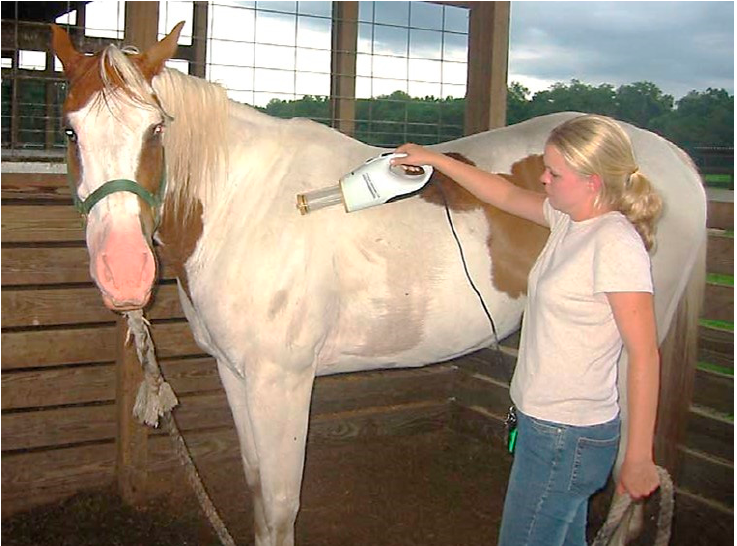
Figure 6. Vacuuming mosquitoes from the Paint gelding using the hand-held portable vacuum